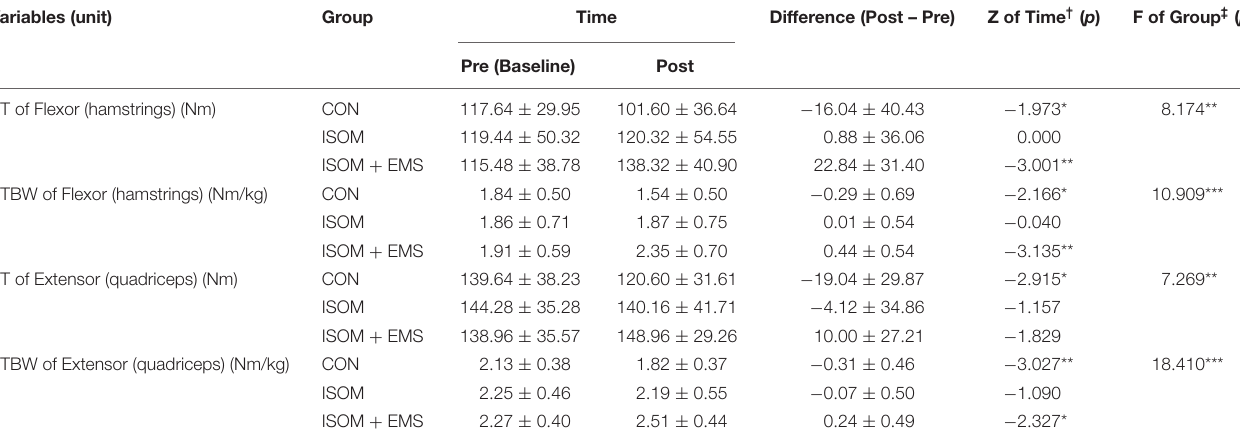
TABLE 7 | Differences and Changes in Isokinetic torques of knee joint at 60 degree/second. Variables (unit) Group Time Difference (Post – Pre) Z of Time ††† ( p ) F of Group ‡‡‡ ( p )